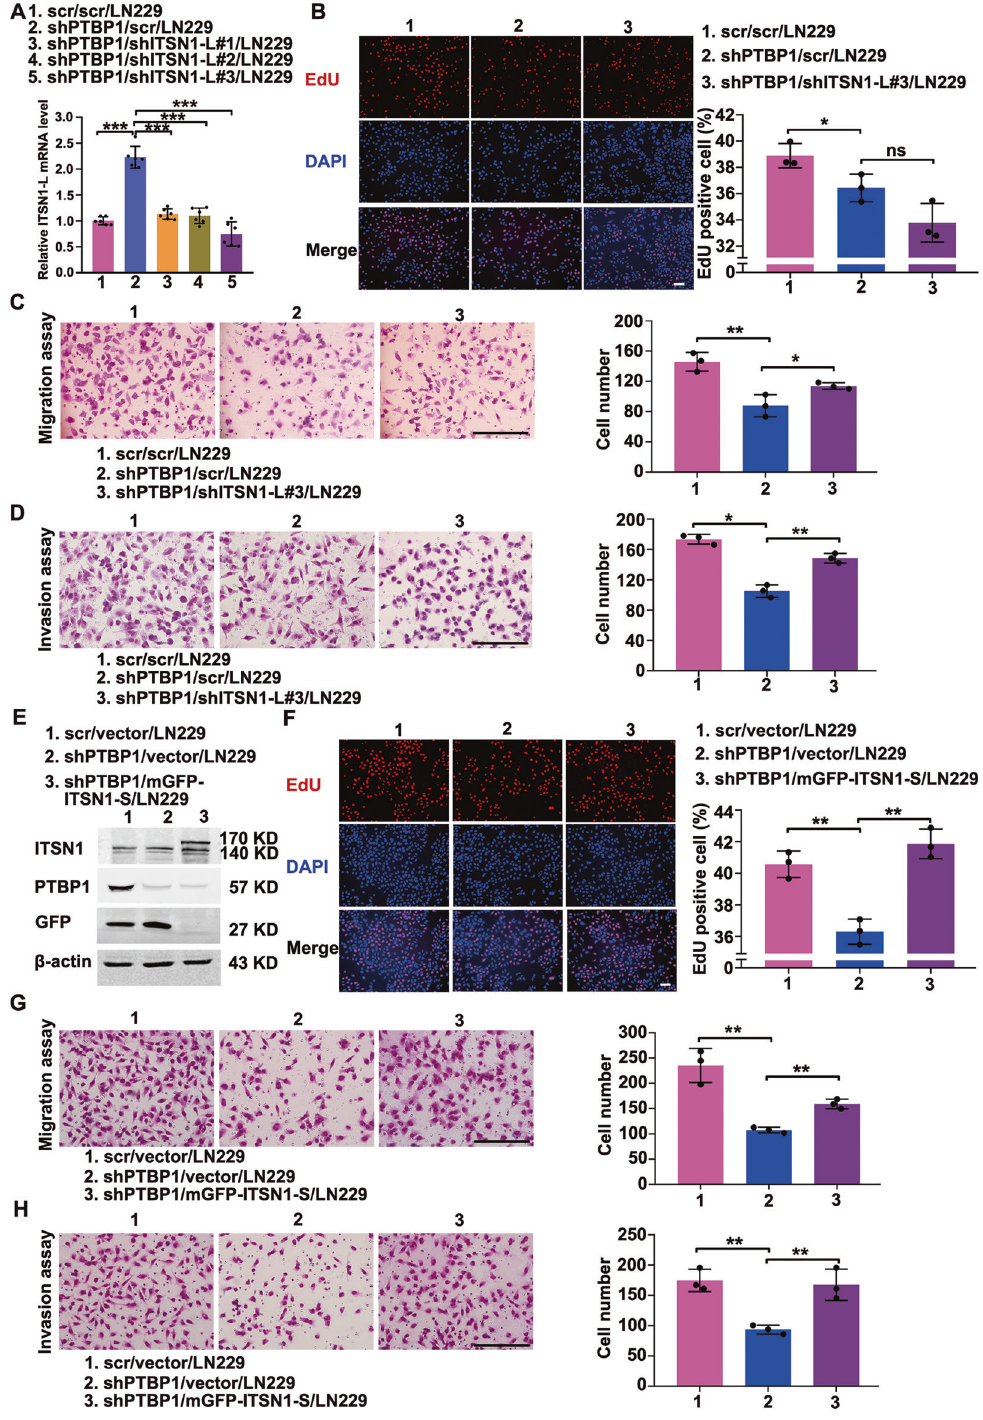
Fig. 6 PTBP1 promoted proliferation, migration, and invasion of glioma cells by regulating alternative splicing of ITSN1 in vitro. A Establishment and veri fi cation of stable cell lines silencing PTBP1 followed by knocking down of ITNS1-L, Values were expressed as mean ± SD from six independent experiments (two-tailed Student ’ s t test, *** P < 0.001). B Images of EdU staining (left, scale bars, 100 μ m) and the comparison of EdU-positive rates among indicated cells (right). C Migration assay of the indicated cells. Cells migrating through transwell inserts were stained, photographed, and quanti fi ed. Scale bars, 200 μ m. D Invasion assay results. Cells invading through matrigel matrix- coated transwell inserts were stained, photographed, and quanti fi ed. Scale bars, 200 μ m. E Western blot analysis of stable cell lines silencing PTBP1 followed by overexpression of ITSN1-S. F Images of EdU staining (left, scale bars, 100 μ m) and the comparison of EdU-positive rates among indicated cells (right). G Migration assay of the indicated cells. Cells migrating through transwell inserts were stained, photographed, and quanti fi ed. Scale bars, 200 μ m. H Invasion assay of the indicated cells. Cells invading through matrigel matrix-coated transwell inserts were stained, photographed, and quanti fi ed. Scale bars, 200 μ m. Values were expressed as mean ± SD from three independent experiments in ( B – D ) and ( F – H ) (two-tailed Student ’ s t test, * P < 0.05, ** P < 0.01, ns, no signi fi